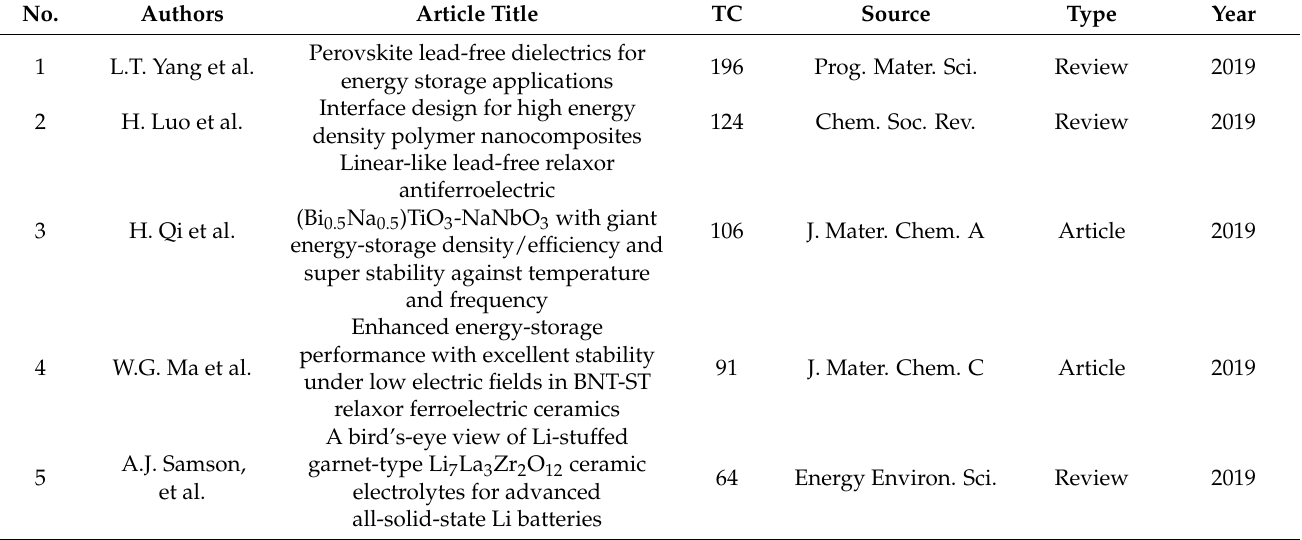
Table 6. Popular ESI papers in energy storage ceramics research